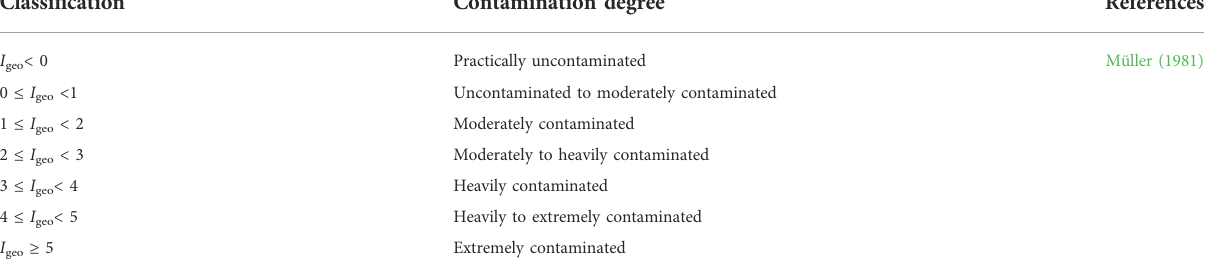
TABLE 1 Classi fi cations of the geoaccumulation index grade ro sediment quality